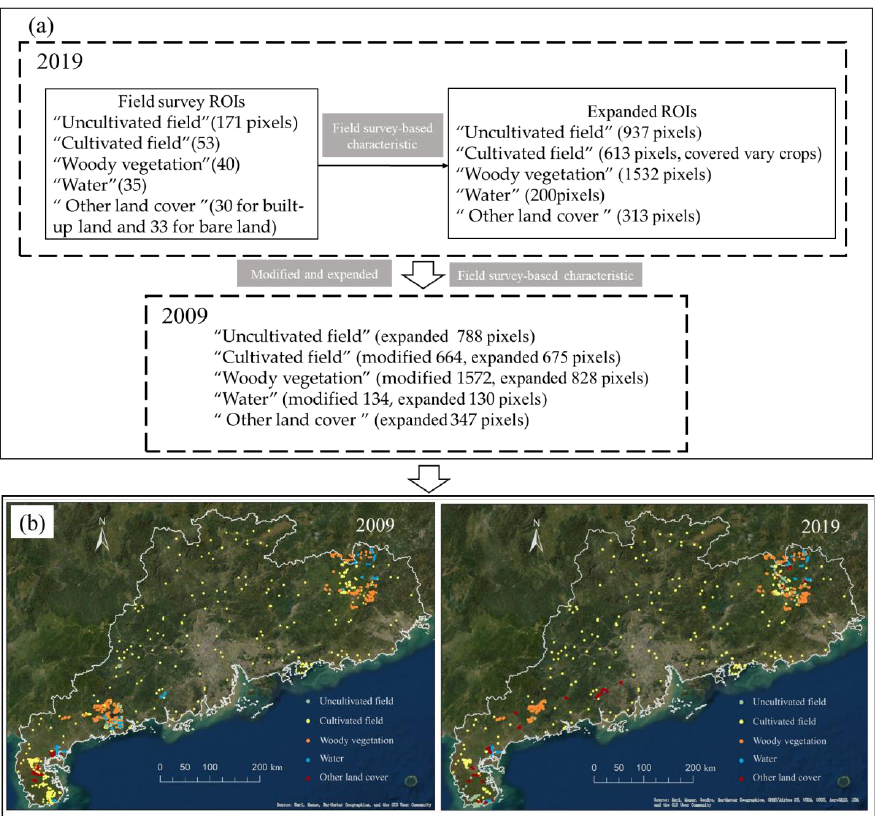
Figure 4. Number ( a ) and distribution ( b ) of five land cover types ROIs in 2009 and 2019 for model training and verifying.